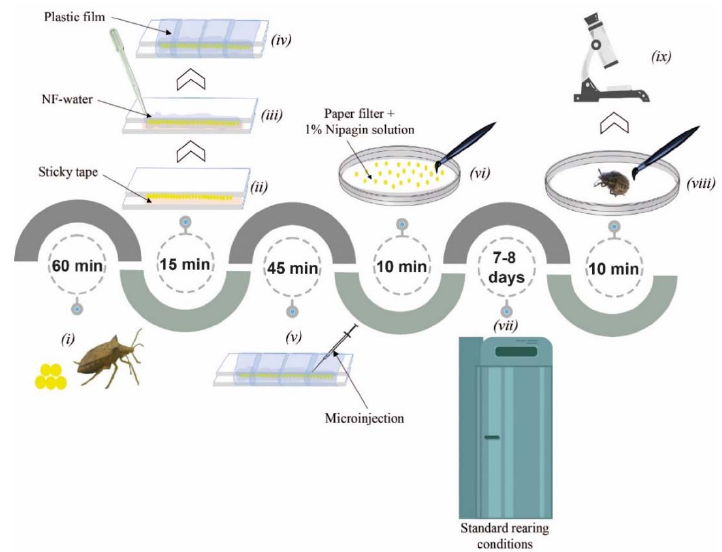
Figure 3. CRISPR/Cas9 workflow for gene editing in E. heros . (i) egg collection (within 60 min after laid), (ii) careful alignment of the eggs over a sticky tape at the junction of two overlapping glass slides, (iii) soaking of eggs with nuclease ‐ free (NF) water (1.5 mL), (iv) wrapping of the glass slides containing the eggs with plastic film to keep the eggs in place and soaked, (v) microinjection of the eggs with CRISPR / Cas9 components (within 45 min), (vi) careful transfer of the injected eggs onto a filter paper slightly soaked with 1% Nipagin solution in a Petri dish. (vii) transfer Petri dishes to normal rearing conditions and check for egg hatching (between 7–8 days). (viii) careful transfer of 1st-nymphs to a new Petri dish, (ix) screen for mutants (genotype and phenotype). Step viii and ix can be flexible depending on the objective of the